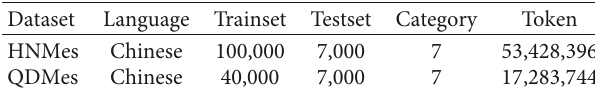
Table 1: Description of datasets.